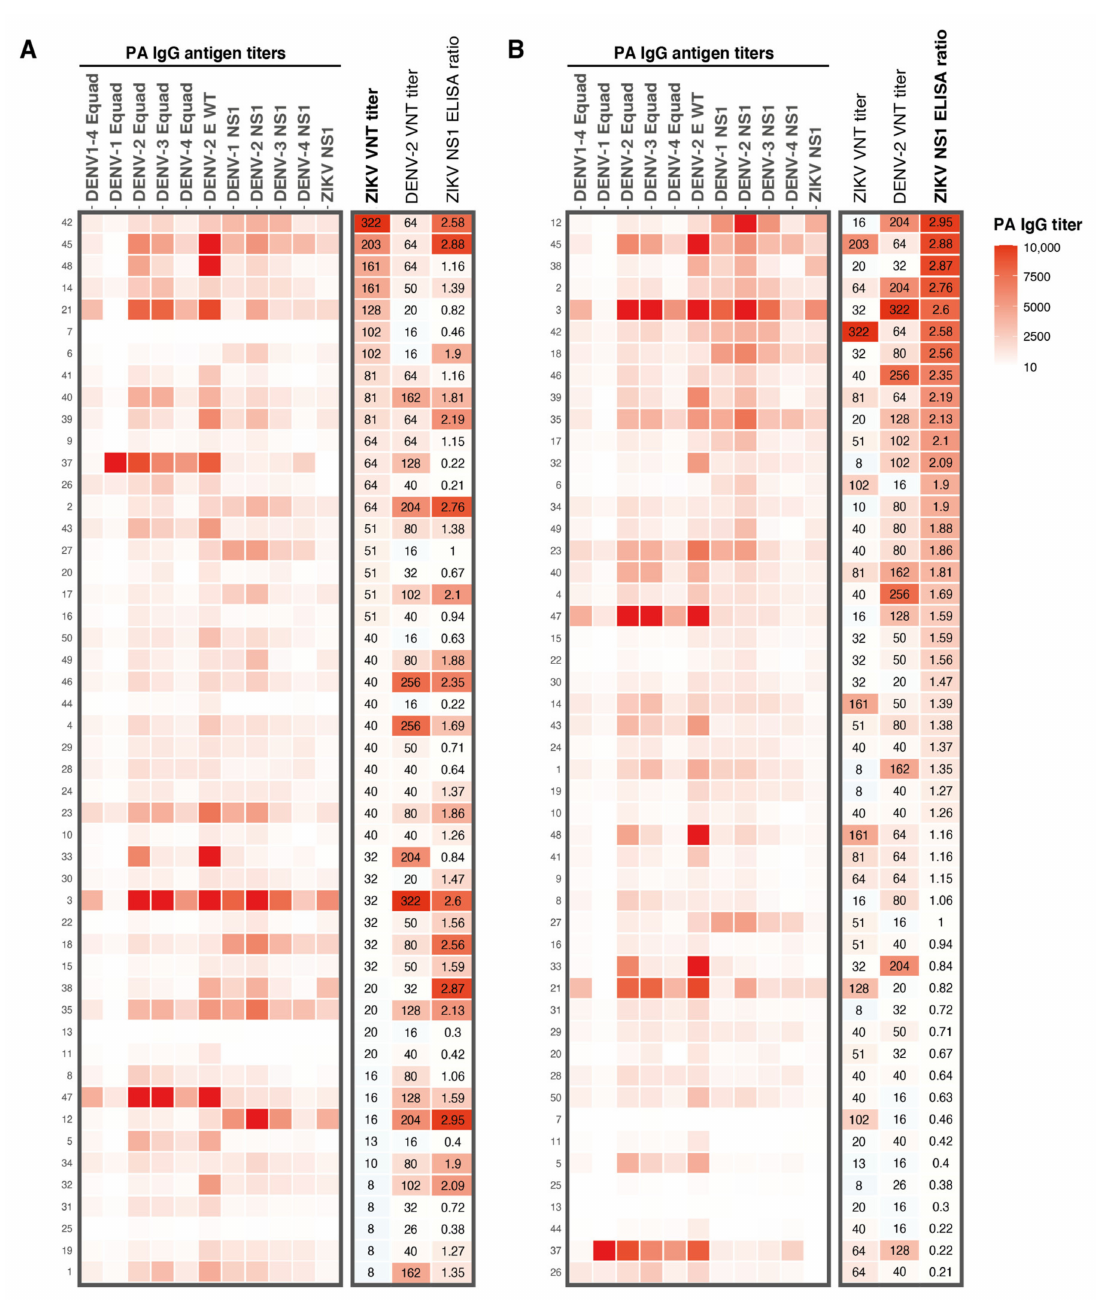
Figure 2. Heatmap of results from the different serological assays used in this study . A : IgG antibody titers for DENV1–4 Equad and DENV1–4 and ZIKV NS1 antigens determined with a protein microarray. Corresponding ZIKV and DENV-2 VNT titers and ZIKV NS1 IgG ELISA ratios from all participants are shown on the right. Antibody patterns are ranked from highest to lowest ZIKV VNT titer. B : Protein microarray IgG antibody titer patterns for DENV1–4 Equad and DENV1–4 and ZIKV NS1, ZIKV and DENV-2 VNT titers and ZIKV NS1 IgG ELISA ratios from all participants, ranked from highest to lowest ZIKV NS1 ELISA ratio. Numbers on the left Y-axis are the study numbers of the participants in this study. PA; protein microarray, Equad; envelope proteins containing four amino acid mutations in the highly conserved fusion loop domain to reduce flavivirus cross-reactivity, VNT; virus neutralization